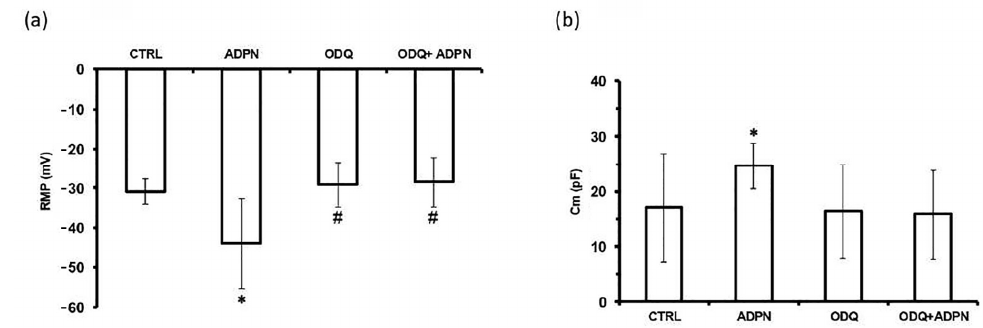
Figure 2. The effects of adiponectin (ADPN) on resting plasma membrane (RMP) potential and membrane capacitance (Cm) of gastric fundus smooth muscle cells (SMCs) involve guanylate cyclase (GC) activity. ( a ) RMP evaluation (in mV) in the untreated specimen (CTRL, n = 5), ADPN (20 nM)-treated (ADPN, n = 6), selective GC inhibitor 1H-[1,2,4] oxadiazolo[4,3- α ]-quinoxalin-1-one (ODQ, 1 µ M)-treated (data related to 5 min ODQ exposure; ODQ, n = 4), and ADPN added in the concomitant presence of ODQ and stimulation repeated after 15 min of exposure (ODQ + ADPN, n = 4). ( b ) Evaluation of Cm (in pF) as an index of the cell surface. Control SMCs (CTRL, n = 21), ADPN-treated (ADPN, n = 6), ODQ-treated (ODQ, n = 4), and ADPN-treated in the presence of ODQ (ODQ + ADPN, n = 5). Data are expressed as mean ± SD. n is the number of SMCs. * p < 0.05 vs. CTRL; # p < 0.05 vs. ADPN (one-way ANOVA with Bonferroni’s correction). Table 1. Effects of different treatments on passive properties of gastric fundus smooth muscle cells (SMCs).